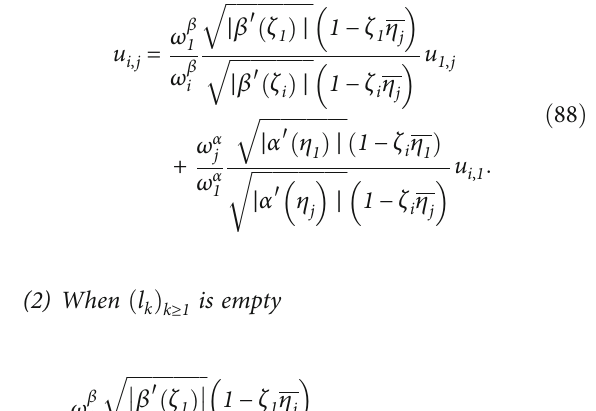
ffiffiffiffiffiffiffiffiffiffiffiffiffiffiffiffi (cid:12) β ′ ζ ð Þ (cid:12) 1 ffiffiffiffiffiffiffiffiffiffiffiffiffiffiffi (cid:12) β ′ ζ ð Þ (cid:12) i